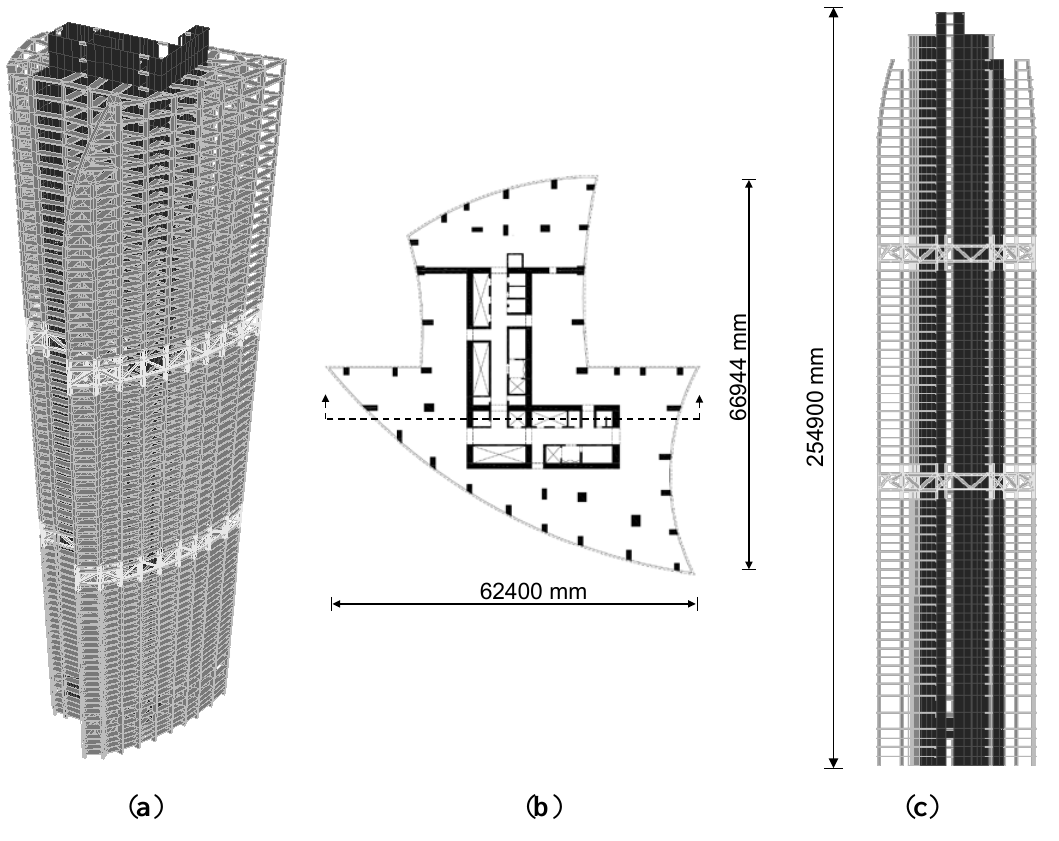
Figure 5. 72-story high-rise building (Tower 2). ( a ) Perspective view; ( b ) Typical floor plan; ( c ) Vertical